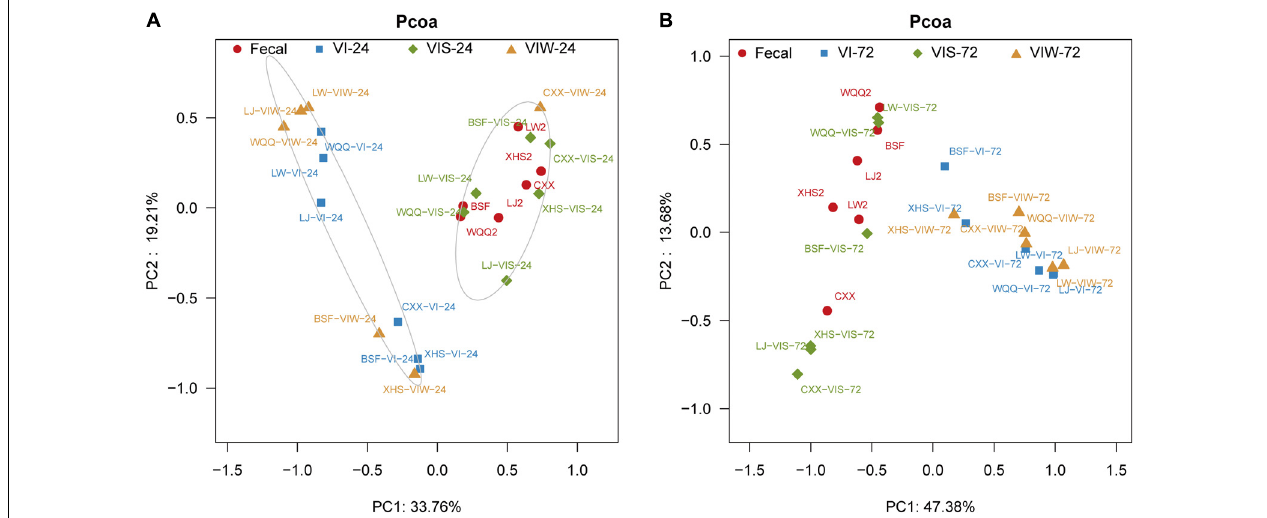
FIGURE 3 | PCoA analysis of the microbial composition of samples. “Fecal” represents original fecal samples. “VIW” and “VIS” represent fermented samples adding EPS-m2 and starch, respectively. “24” and “48” represents the fermentation time of 24h (A) and 48h (B) . VI represents the fermented samples using VI